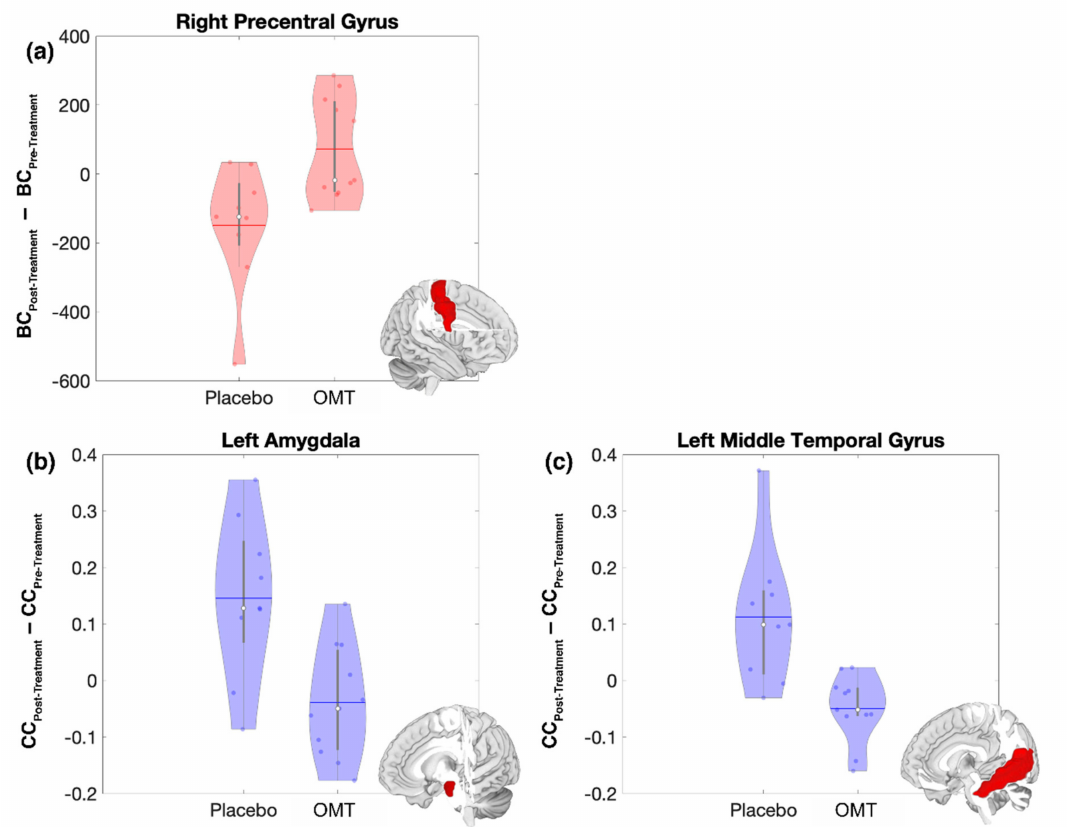
Figure 3. Pre to Post-treatment changes of brain functional topological measures in the Right Precentral Gyrus ( a ), Left Amygdala ( b ) and in the Left Middle Temporal Gyrus ( c ). Violin plots of the statistically significant di ff erence between the post-treatment and pre-treatment values of Betweenness Centrality (BC, red) and Clustering Coe ffi cient (CC, blue) for the Osteopathic Manipulative Treatment (OMT) and Placebo (P). The solid horizontal lines represent the mean of the distribution, while the white dots represent the median. For each plot the structural representation of the associated region is reported as the red portion of the whole brain (right Precentral Gyrus, left Amygdala and left Middle Temporal Gyrus